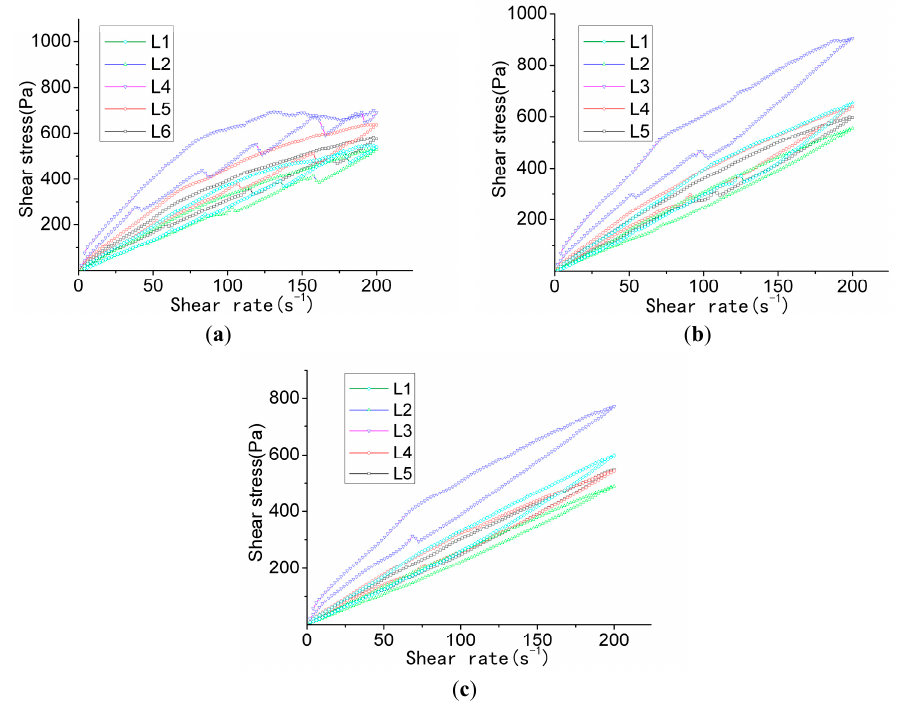
Figure 4. Testing of thixotropy. ( a ) Thixotropy test (hydration for 1 min); ( b ) Thixotropy test (hydration for 31 min); ( c ) Thixotropy test (hydration for 121 min). Table 7. Thixotropy of the slurry.